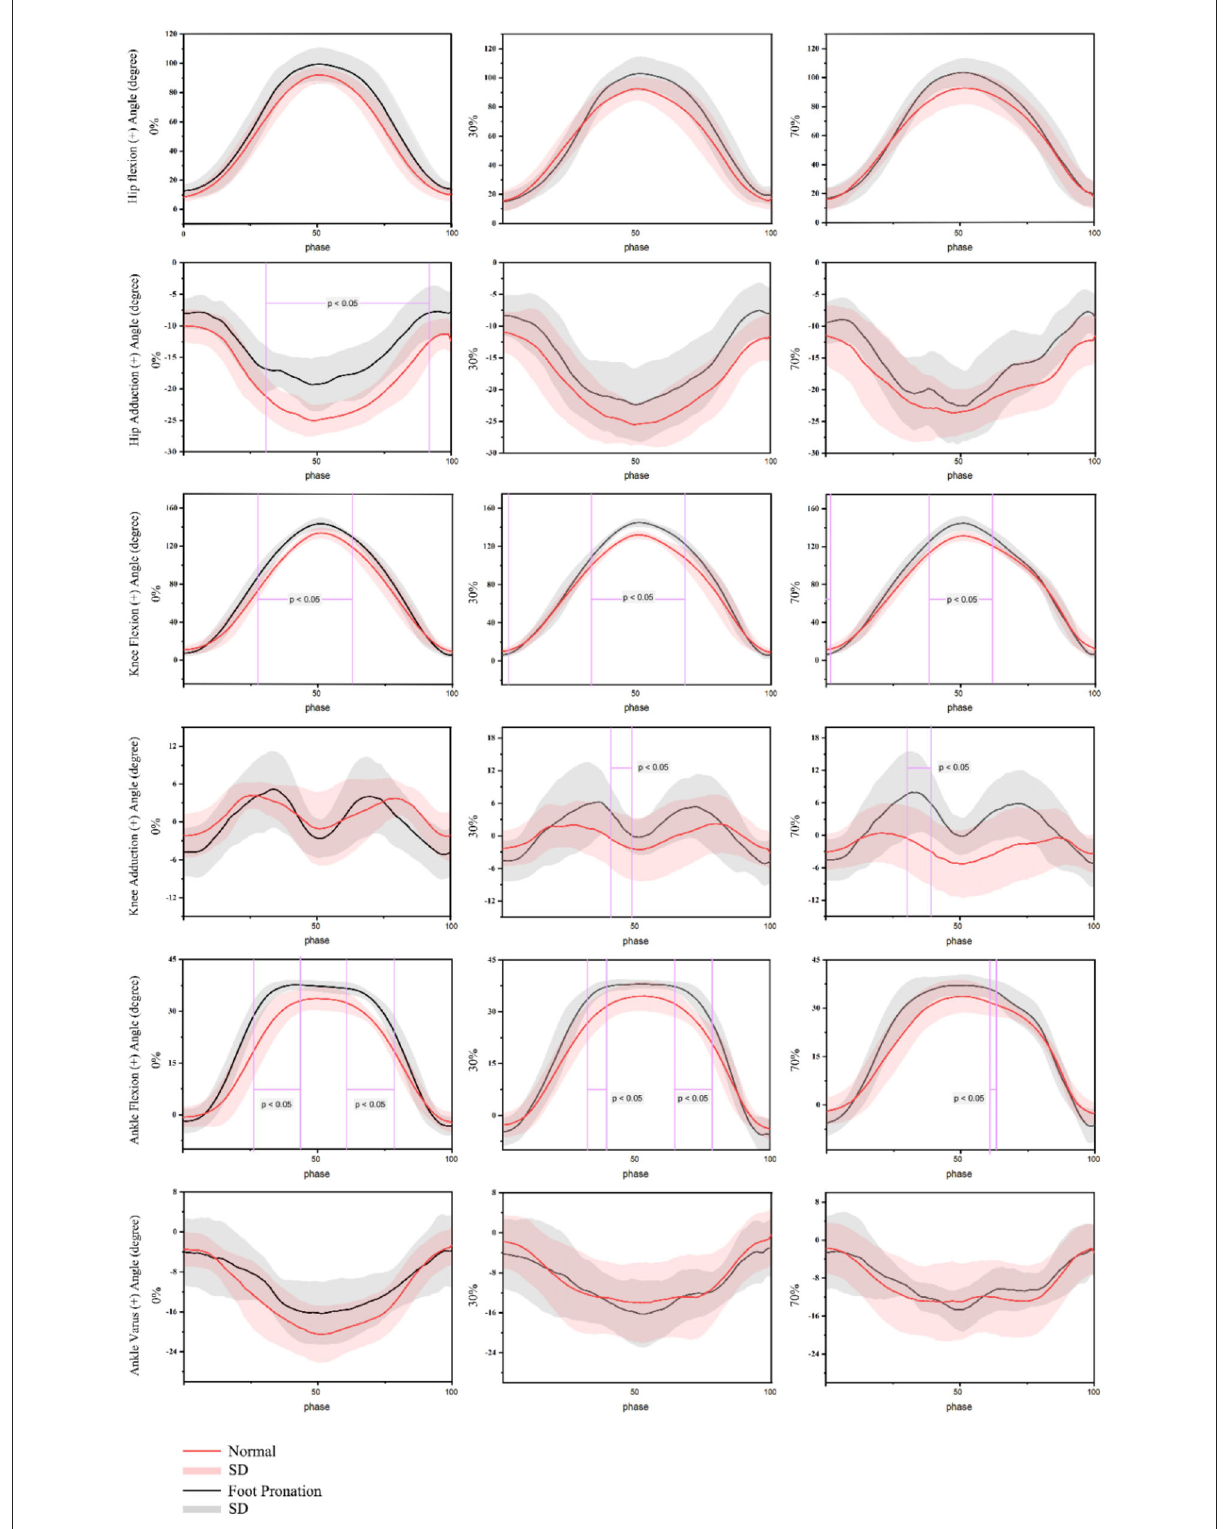
FIGURE4 Angle of barbell squat joint in people with pronation foot and those with normal foot